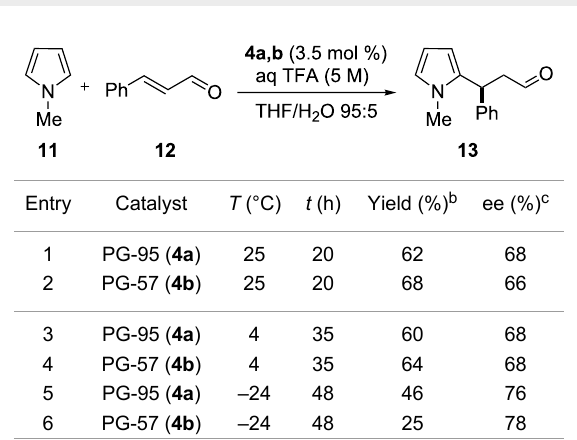
Table 2: Influence of temperature in the Friedel–Crafts alkylation.